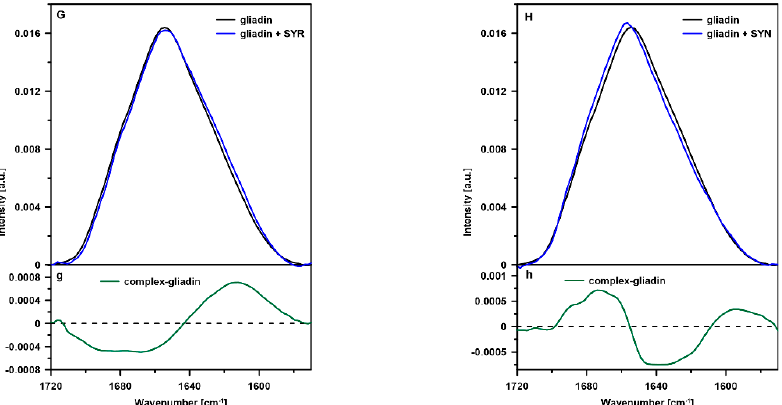
Figure 1. FTIR spectra of the gliadin and complexes of gliadin with phenolic acids: 4-xydroxybenzoic (4XY), coumaric (COU), protocatechuic (PCAT), caffeic (CAF), vanillic (VAN), ferulic (FER), syringic (SYR), and sinapic (SYN). Panels ( A – H ) present the original spectra and panels ( a – h ) present the difference spectra. The original, surface-normalized spectra are presented in the amide I region (1570–1720 cm − 1 ).